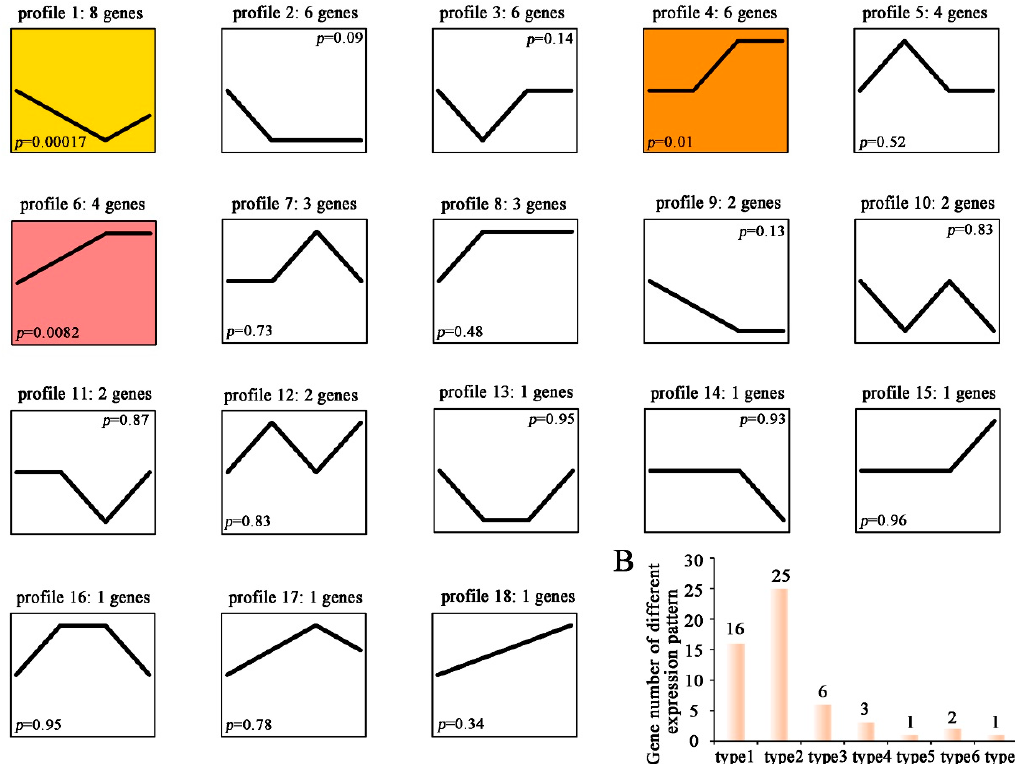
Figure 6. Expression profiles of C6 zinc domain genes under different light conditions in T. guangdongense . ( A ), Expression patterns of differentially expressed genes; ( B ), Gene classification based on the Expression patterns. Type 1 represented genes immediately increased expression levels after light treatment. Type 2 represented genes immediately decreased expression levels after light treatment. Type 3 represented genes showing no change in expression levels when light treatment for 30 min, but increased firstly and then stabilized expression pattern after light treatment for 30 min. Type 4 represented genes showing no change in expression levels when light treatment for 30 min, but increased firstly and then returned to the starting level after light treatment for 30 min. Type 5 represented gene showing no change in expression levels at first, but up-regulation after light treatment for four hours. Type 6 represented genes showing no change in expression levels when light treatment for 30 min, but decreased firstly and then returned to the starting level after light treatment for 30 min. Type 7 represented gene showing no change in expression levels at first, but down-regulation after light treatment for four